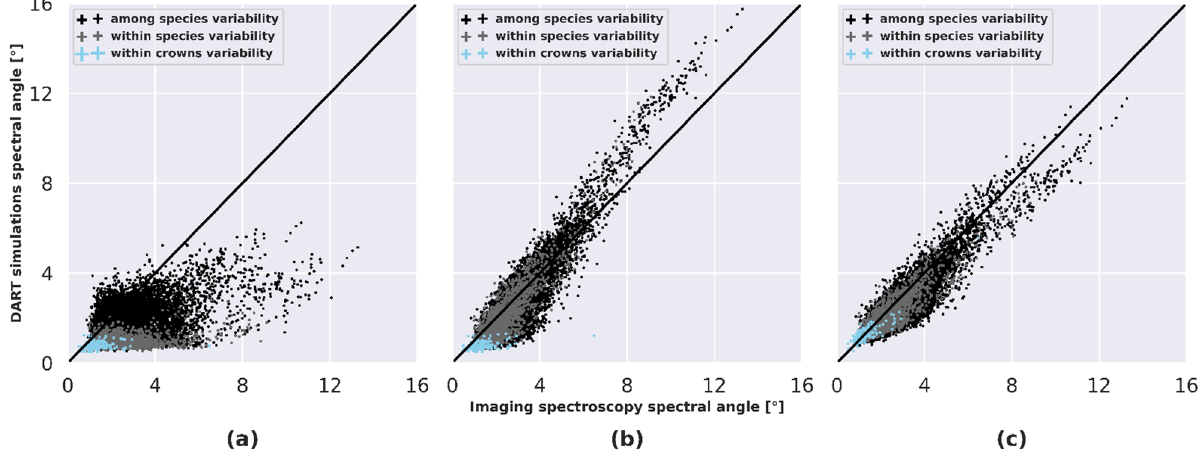
Figure 11. Relationship between spectral dissimilarity computed for experimental imaging spectroscopy and DART simulations based on spectral angle. ( a ) LOP species level; ( b ) LOP ITC level; ( c ) LOP pixel level. Table 2. Pearson’s correlation coefficient and RMSE computed when comparing spectral dissimilarity from imaging spectroscopy and from DART simulations for the different LOP variability scenarios. Spectral dissimilarity is compared within crowns, within species and among species.